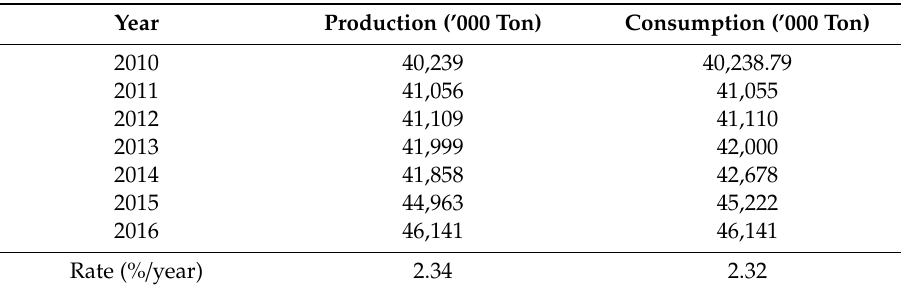
Table 1. Rice production and consumption in 2010–2016.